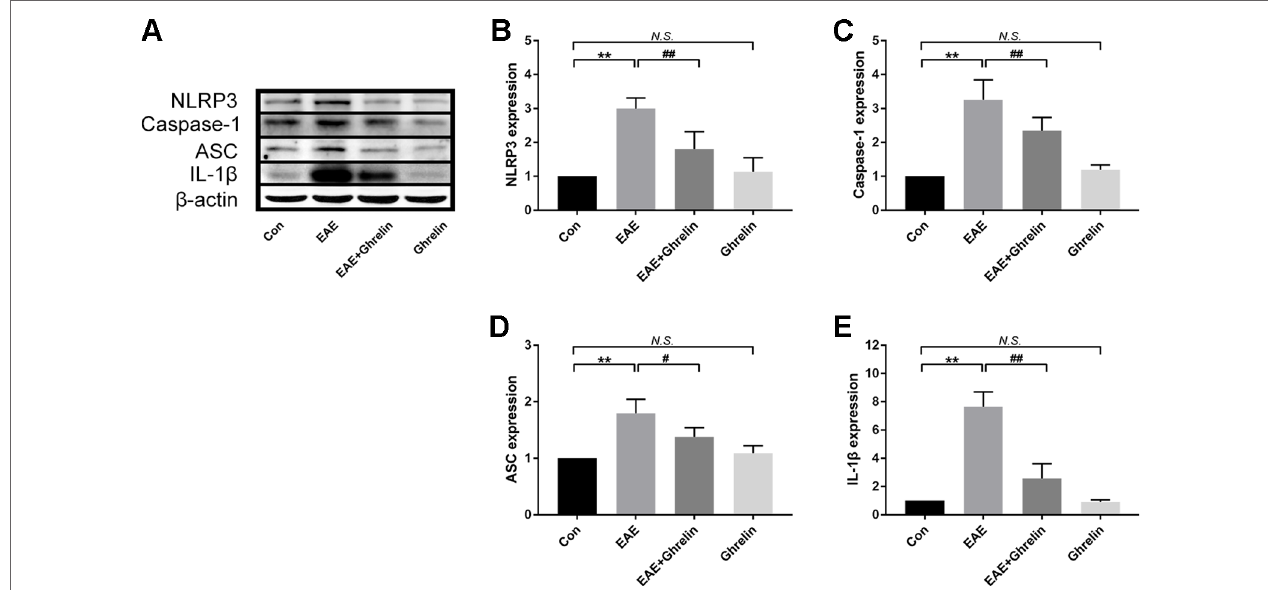
FIGURE 4 | Treatment of ghrelin inhibited the NLRP3 signaling pathway in EAE rats. (A) Representative western blot images of changes in the expression level of NLRP3, ASC, caspase-1, and IL-1β. (B–E) β-Actin was used as internal control to calculate relative expression. Data were shown as mean ± SD ( n = 5). ** P 0.01 versus the control group, # P 0.05, ## P 0.01 versus the EAE group. NS , not significant. Con, control.